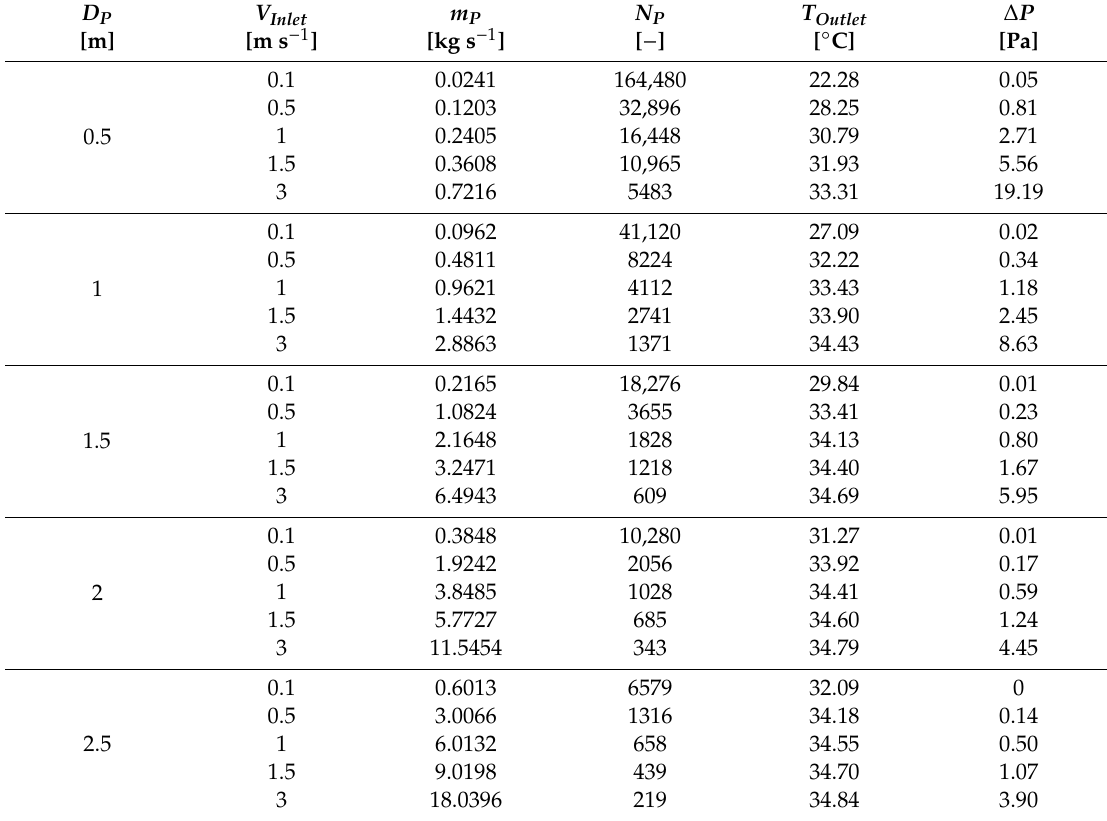
Table 7. Quantitative results of pipe diameter